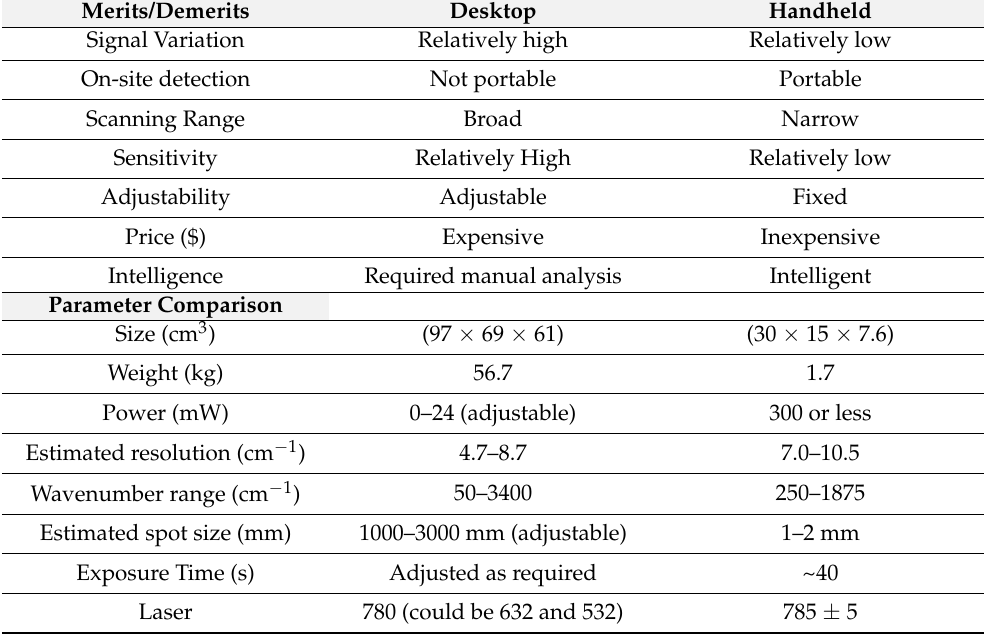
Table 2. A comparative assessment of the bench-top and portable Raman device manufactured by Thermo Scientific Company. Table adapted with permission from [84]. Copyright 2014 Elsevier. Merits/Demerits Desktop Signal